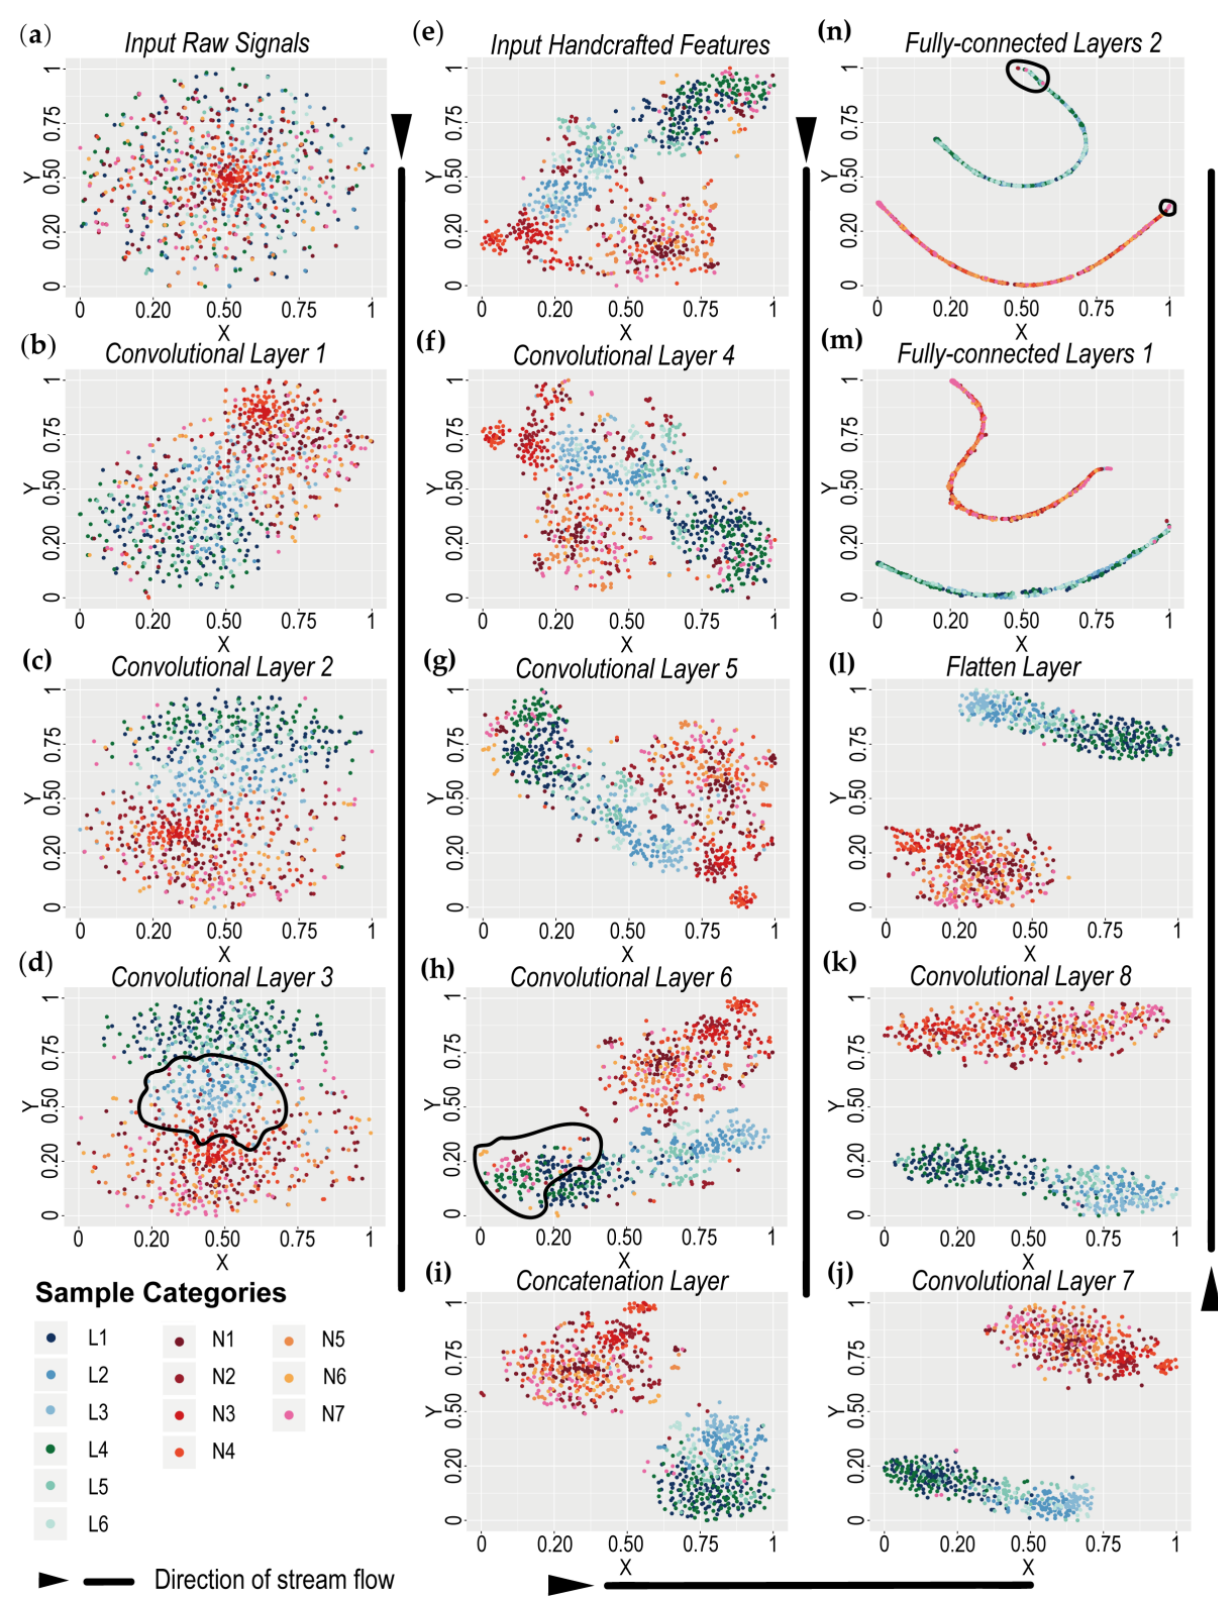
Figure 15. The feature map distributions of the test set derived from the input layers and inner layers of the PCNN model via the t-SNE method: ( a – d ) Feature map distributions in the feature extraction stage; ( e – h ) distributions in the feature engineering stage; ( i – k ) distributions in the feature fusion stage; ( l ) distributions in flatten layer; and ( m , n ) distributions in the classification stage. The black circles in ( d , h ) indicate the aggregation of leak and leak samples, while that in n indicates the mis-